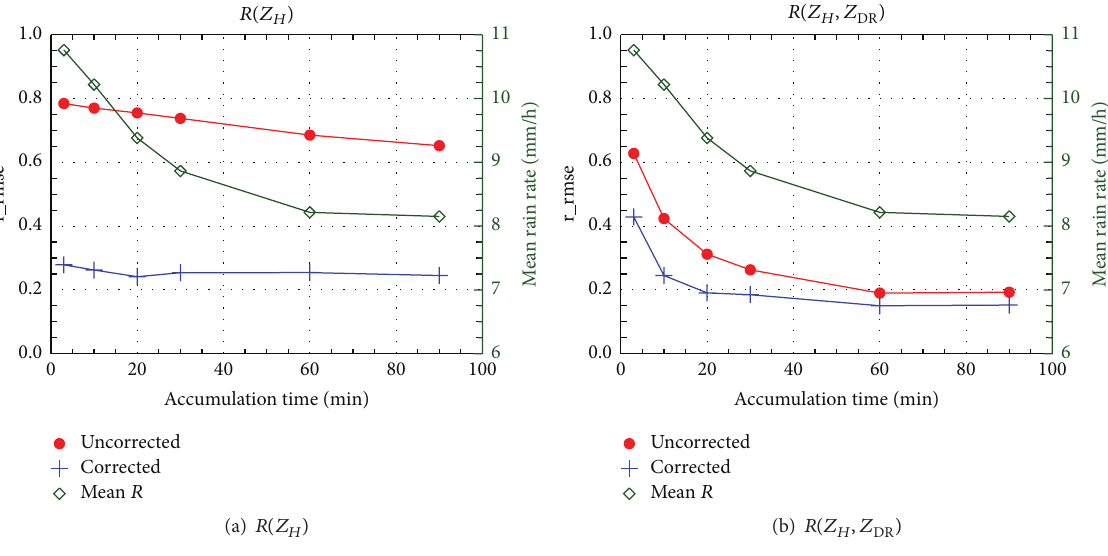
Figure 21: The relative root-mean square error of 𝑅(6 km 2 ) versus 𝐺(6 km 2 ) with an accumulation time (a) using 𝑍 𝐻 and (b) using 𝑍 𝐻 and 𝑍 . The red point-line and the blue point-line indicate without and with the attenuation correction, DR